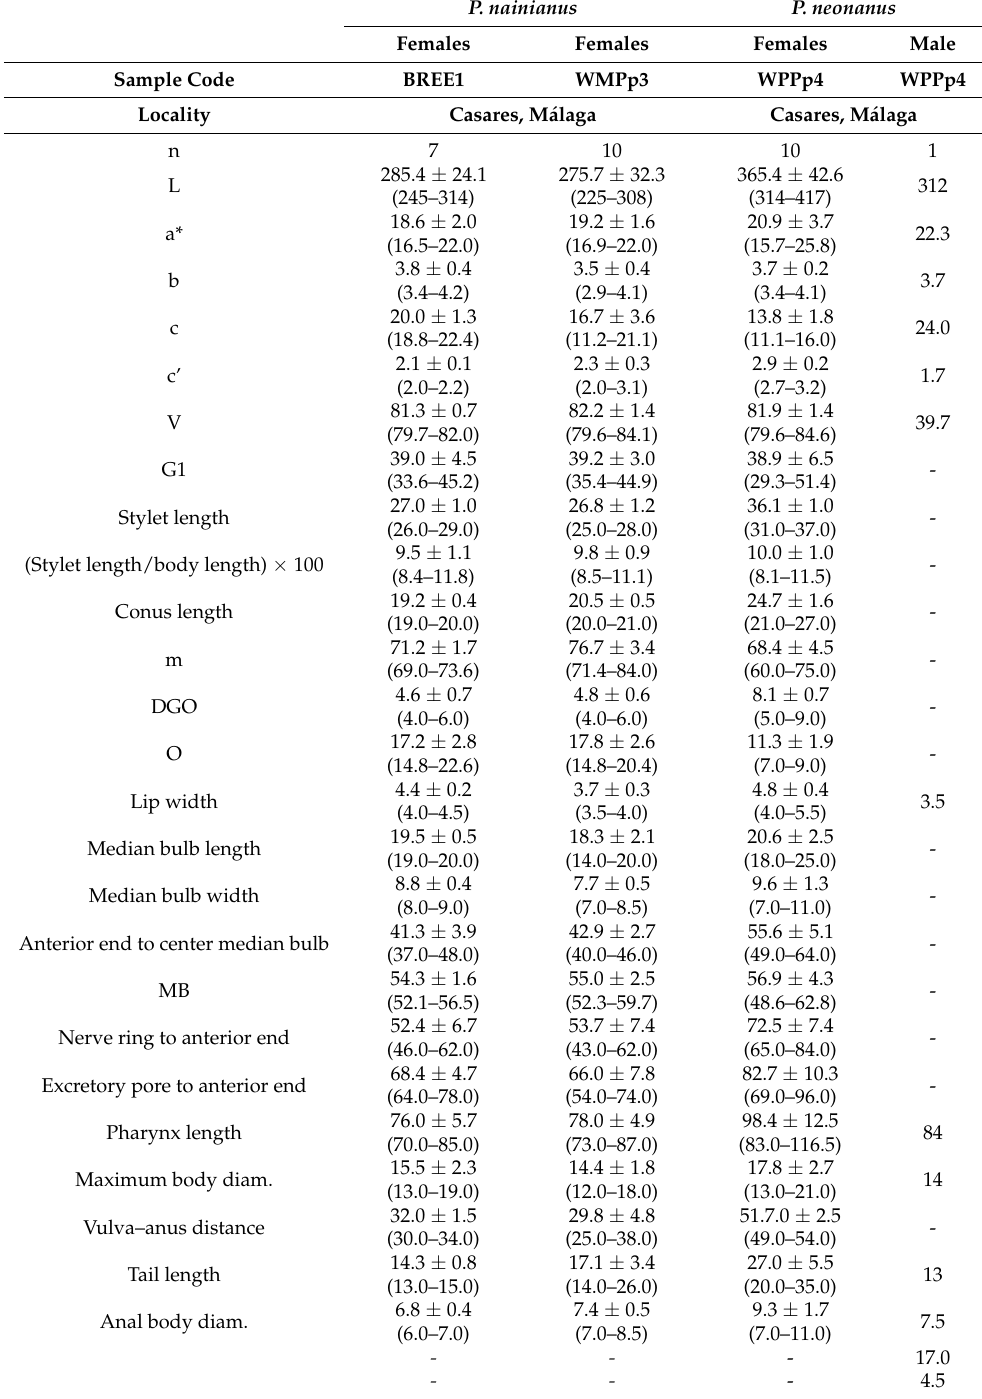
Table 5. Morphometrics of Paratylenchus nainianus Edward & Misra, 1963 females and Paratylenchus neonanus Mathur, Khan & Prasad, 1967 females and male. All measurements are in µ m and in the form: mean ± s.d.